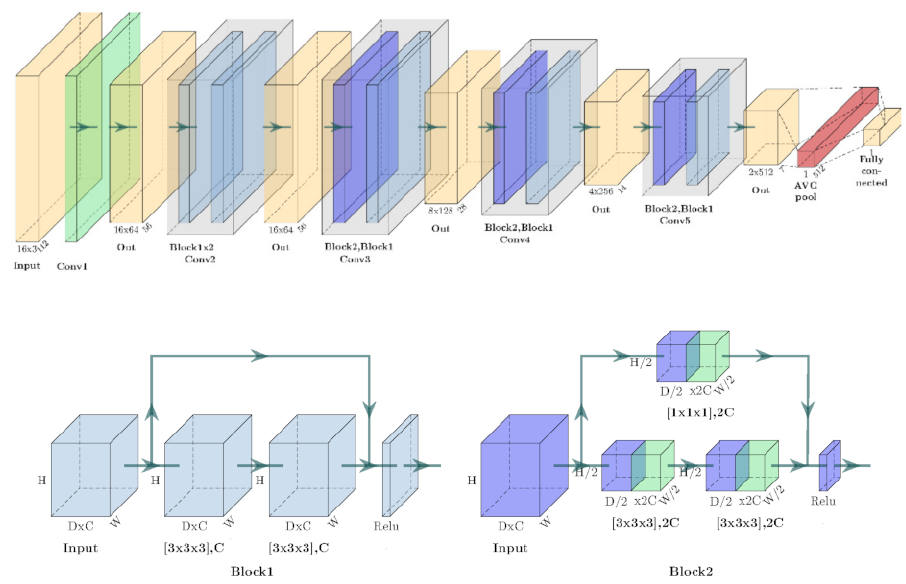
Figure 2. The proposed 3D CNN model. There are two types of residual block in this network, which are detailed in the bottom graph and indicated as different